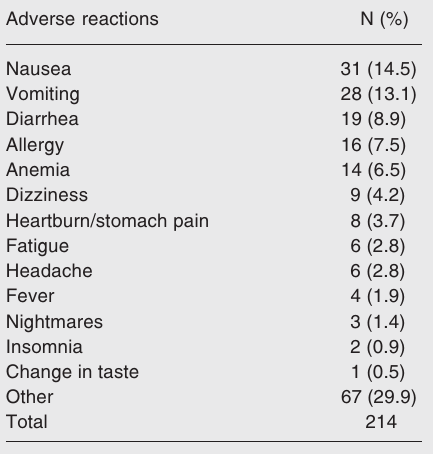
Table 1. Distribution of the total number of ad- verse reactions to antiretroviral (ARV) recorded in the medical charts between the first ARV prescrip- tion and the end of the first year of medical consul- tations, Belo Horizonte, MG, Brazil,